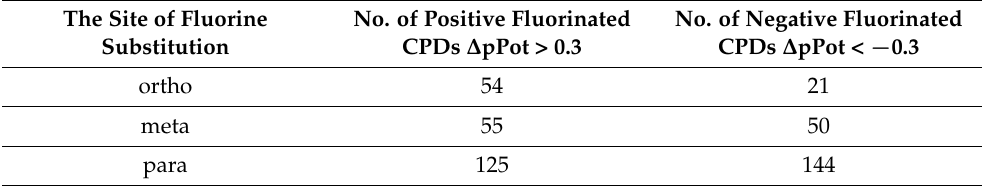
Table 2. The number of fluorinated aromatic ring site of compounds in each ∆ pPot range. The Site of Fluorine